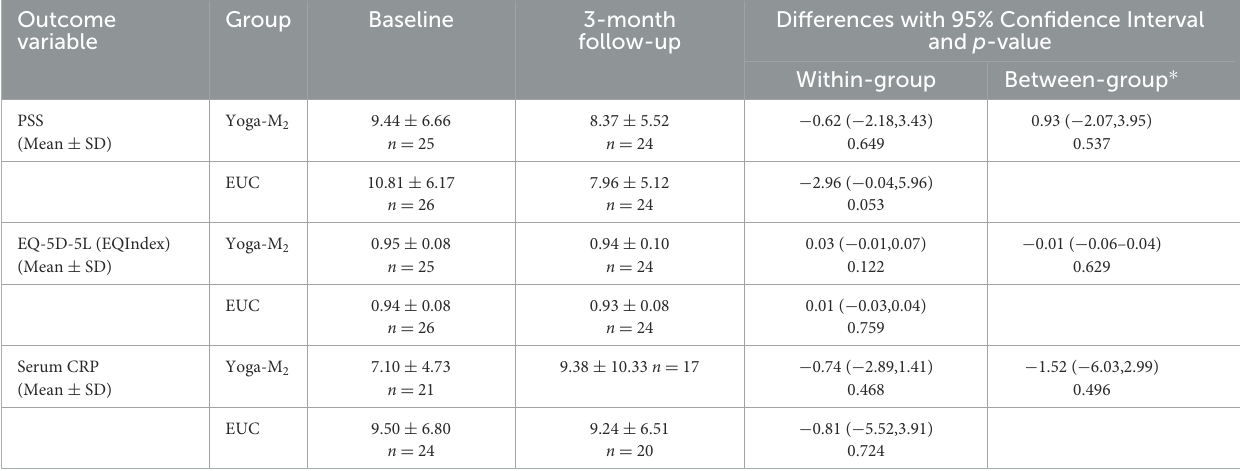
TABLE 2 Summary of the findings related to the preliminary efficacy